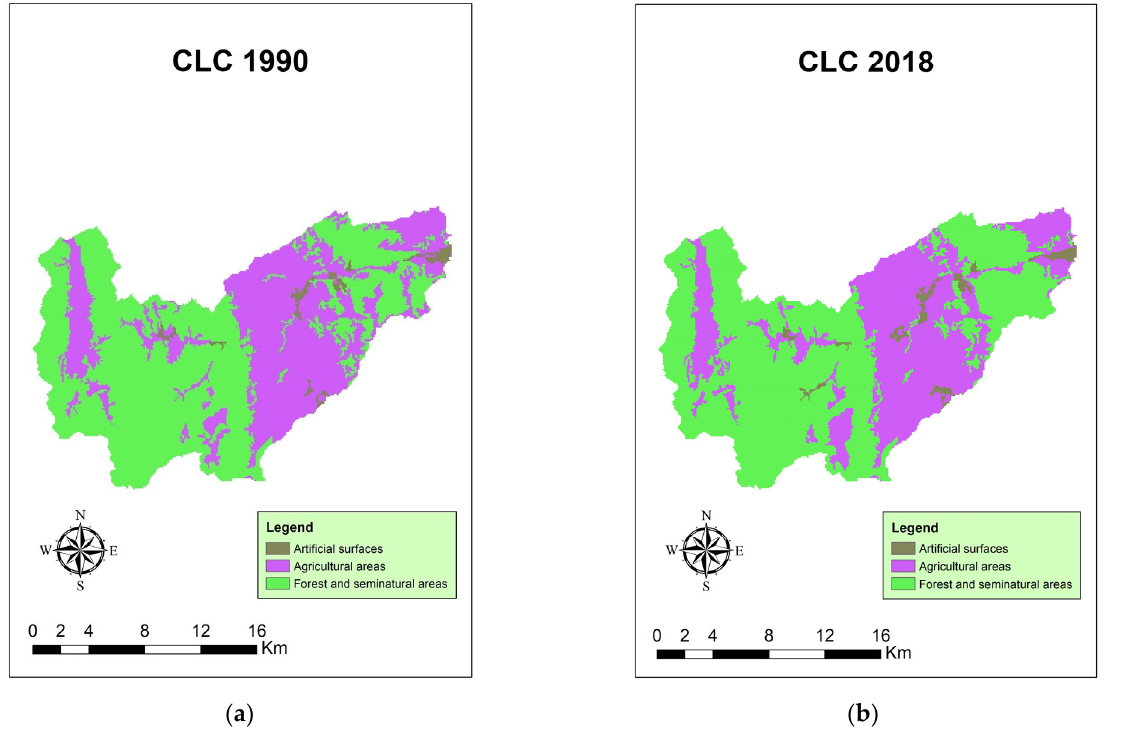
Figure 3. Corinne Land Cover, land use map: ( a ) CLC 1990, ( b ) CLC 2018.